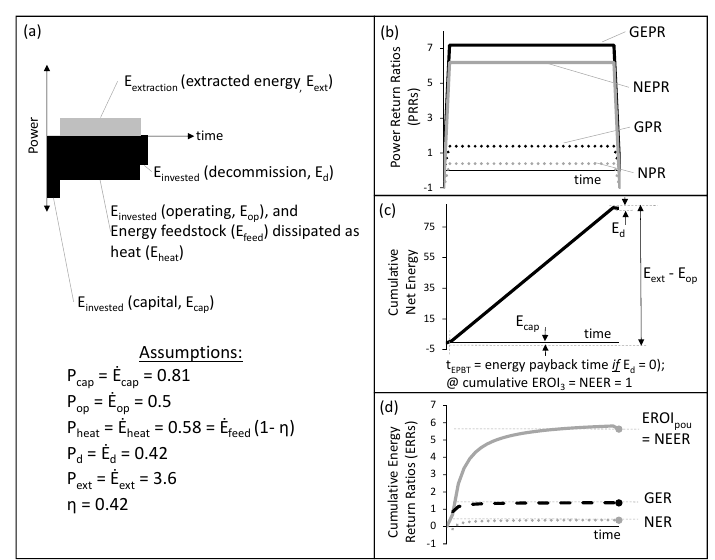
Figure 1. The power flows and energy relations among various factors that are used to calculate energy and power return ratios for single energy technology life cycle (largely following [45] for nomenclature and [46] for input values). ( a ) Pictogram depicting the assumptions and the five types of power flows for this example; ( b ) the instantaneous power return ratios (PRRs) are defined similarly to energy return ratios (ERRs), except using only instantaneous power flow data rather than power integrated over time; ( c ) the cumulative net energy over time is the integral of the instantaneous net power (net power = P out − P in ); ( d ) the cumulative ERR for three common ERRs. EROI 3 = EROI pou (EROI, energy return on energy invested) from [45] equal to the net external energy ratio (NEER) from [29,44,47]. Gross energy ratio (GER) and net energy ratio (NER) from [29]. E, energy.